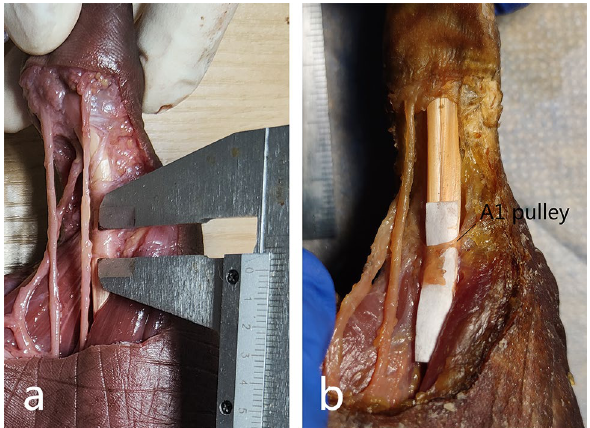
Figure 4. ( a ) The A1 pulley of thumb; ( b ) the A1 pulley after cutting 10 times.